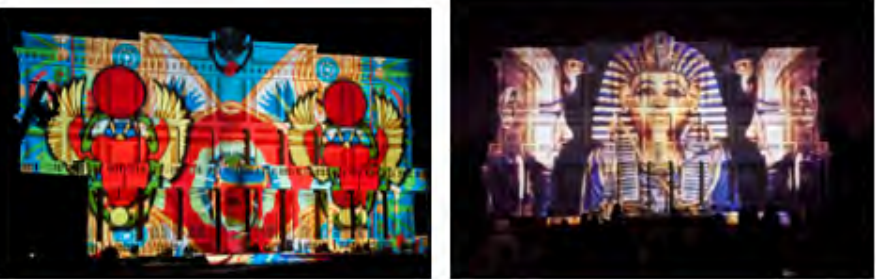
Figure 10. Bourse Building in Media City in